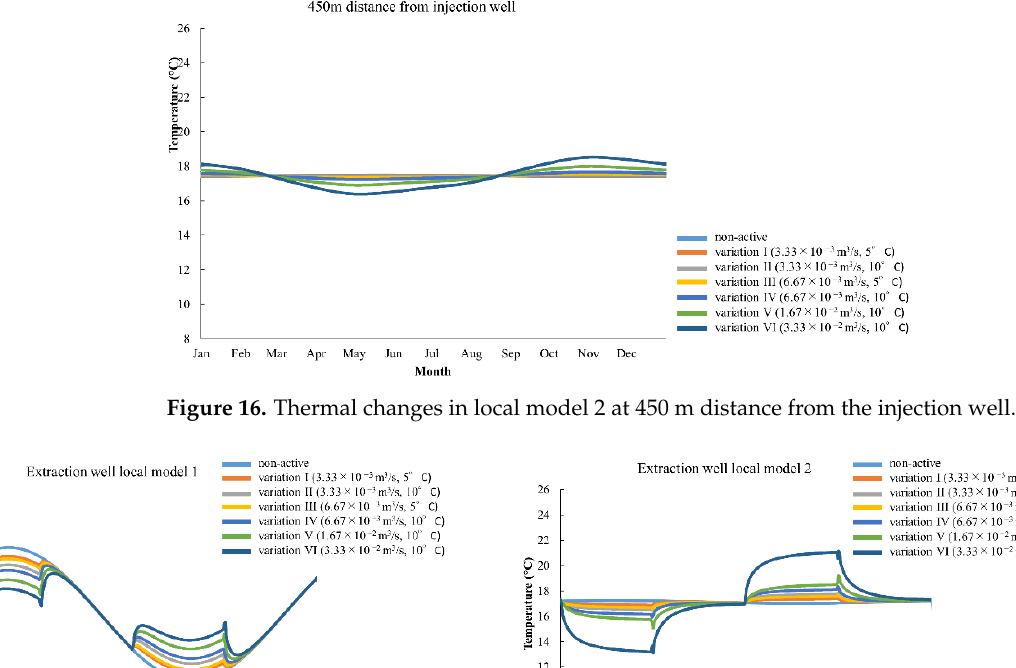
Figure 16. Thermal changes in local model 2 at 450 m distance from the injection well.